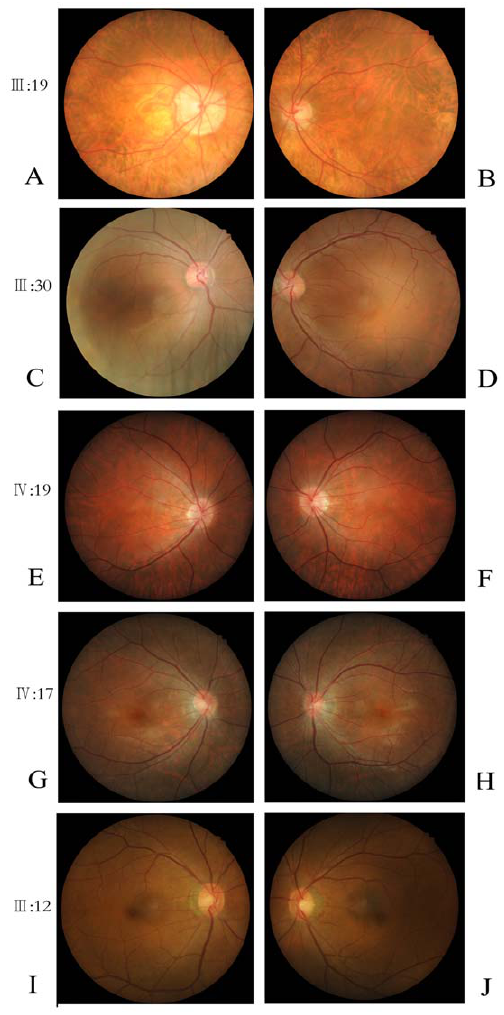
Figure 2. Fundus photographs of three patients, one carrier and one normal individual. A–F: three patients; G–H: one carrier; I–J: one normal individual.